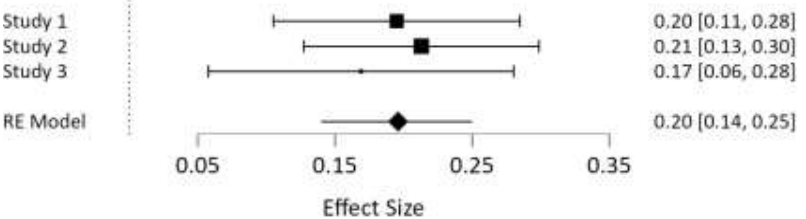
Figure 21. Forest plot of meta-analysis of Motivation for stimulation and Agreeableness